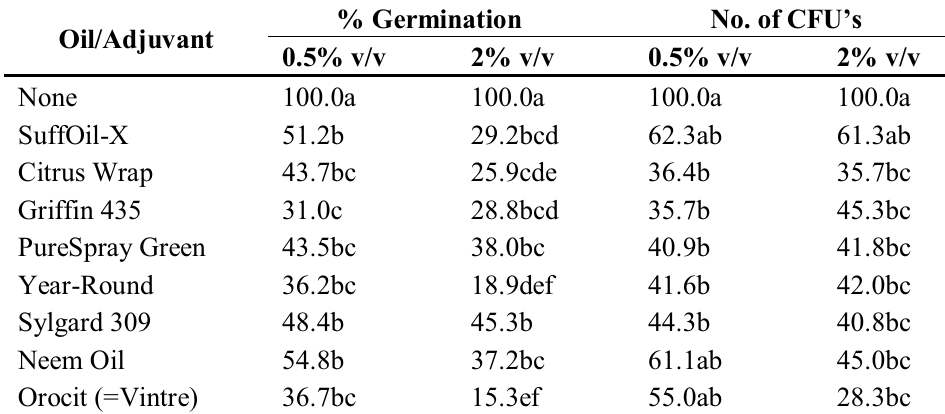
Table 2. Effect of spray oils and adjuvants at two rates on in vitro growth of I. fumosorosea with respect to fungus only